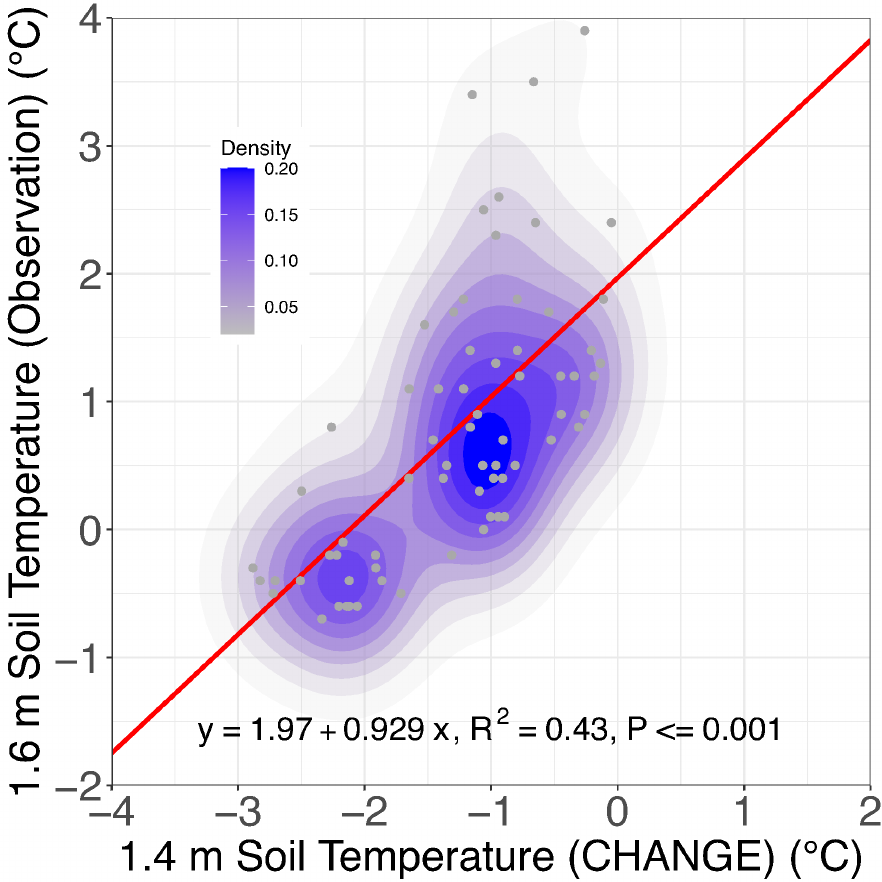
Figure 9. Comparison between observed 1.6 m depth soil temperature and CHANGE-based 1.4 m depth soil temperature in August at sites 24,790, 25,206, 25,400, and 25,428. Colors represent the density of gray circles. Red line denotes linear regression line, which is shown as an equation in the inset of the